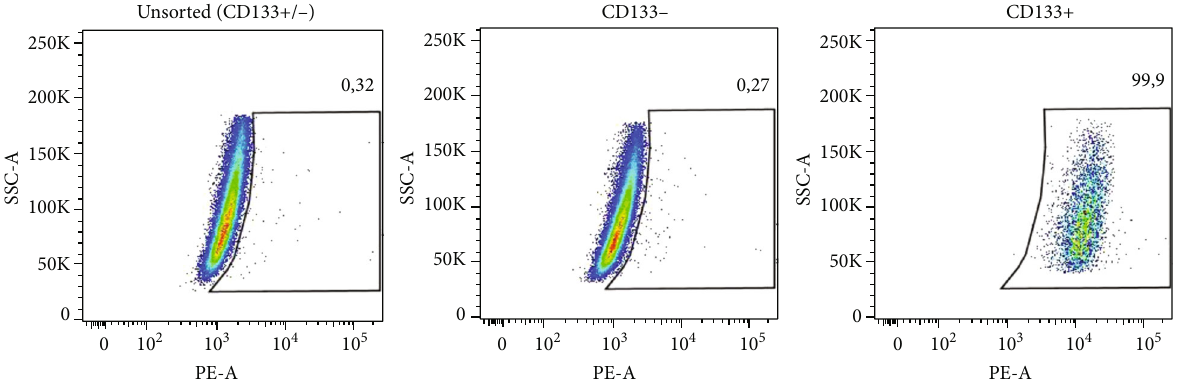
Figure 1: Con fi rmation of proper magnetic separation. Results of fl ow cytometry analysis of unseparated and separated cells stained with anti-CD133-PE